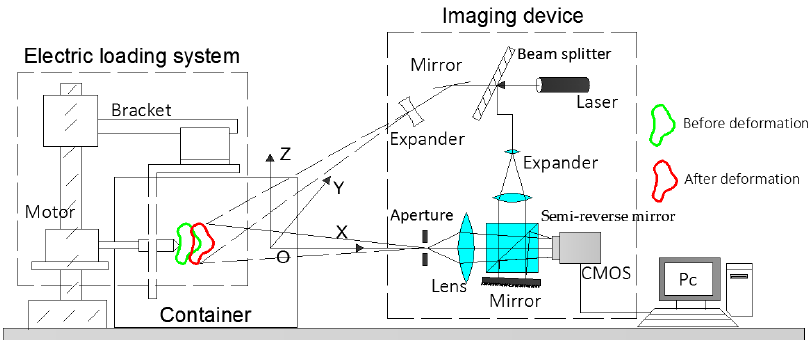
Figure 2. The schematic of the experimental system.